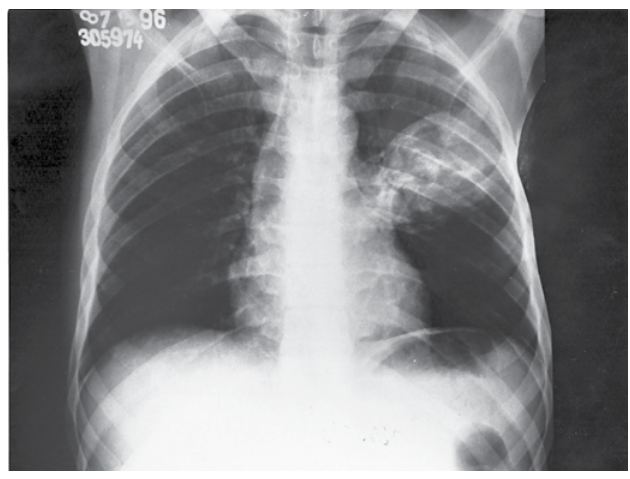
figurE 1 – Chest Radiography showing heterogeneous opacity in the anterior segment of the left upper lobe, rounded, with ill-defined borders, measuring about 6